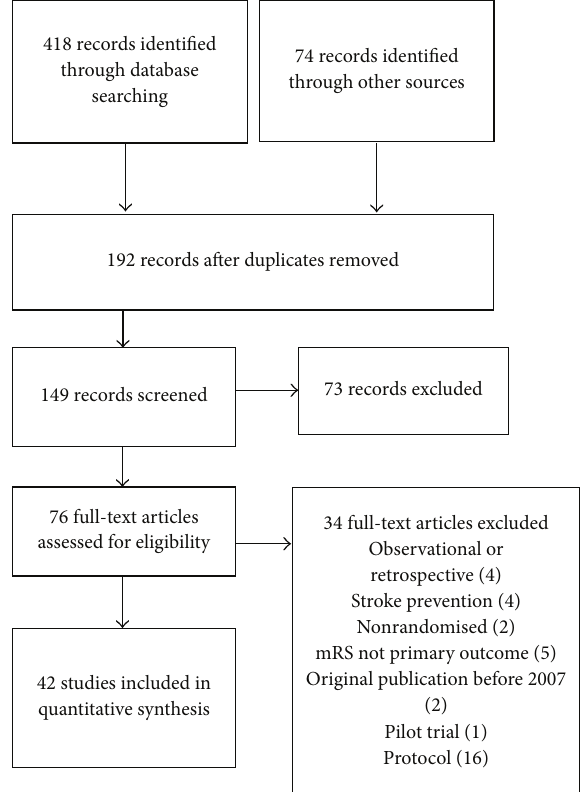
Figure 1: Flow of information through stages of systematic